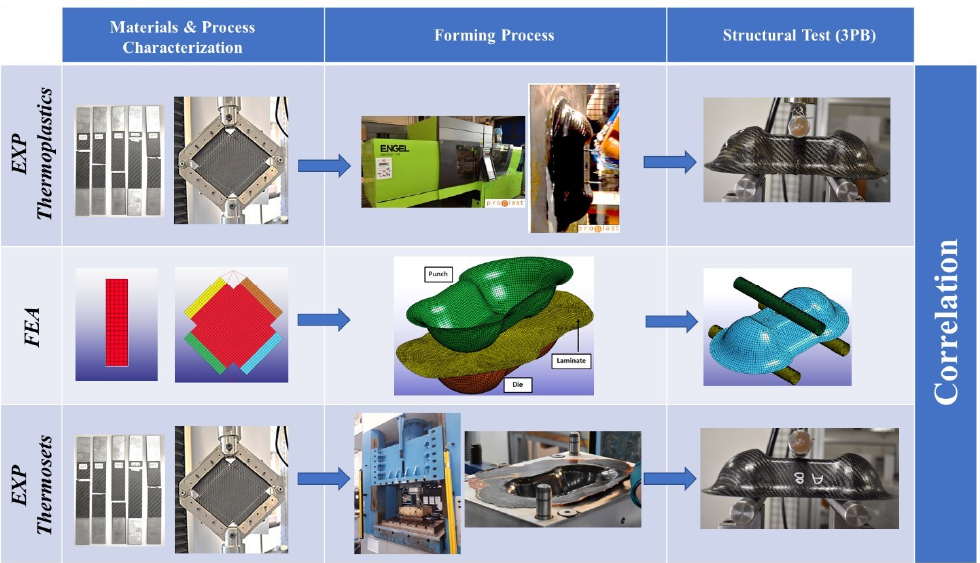
Figure 1. Activity flowchart for the numerical-experimental correlation of Double Dome .